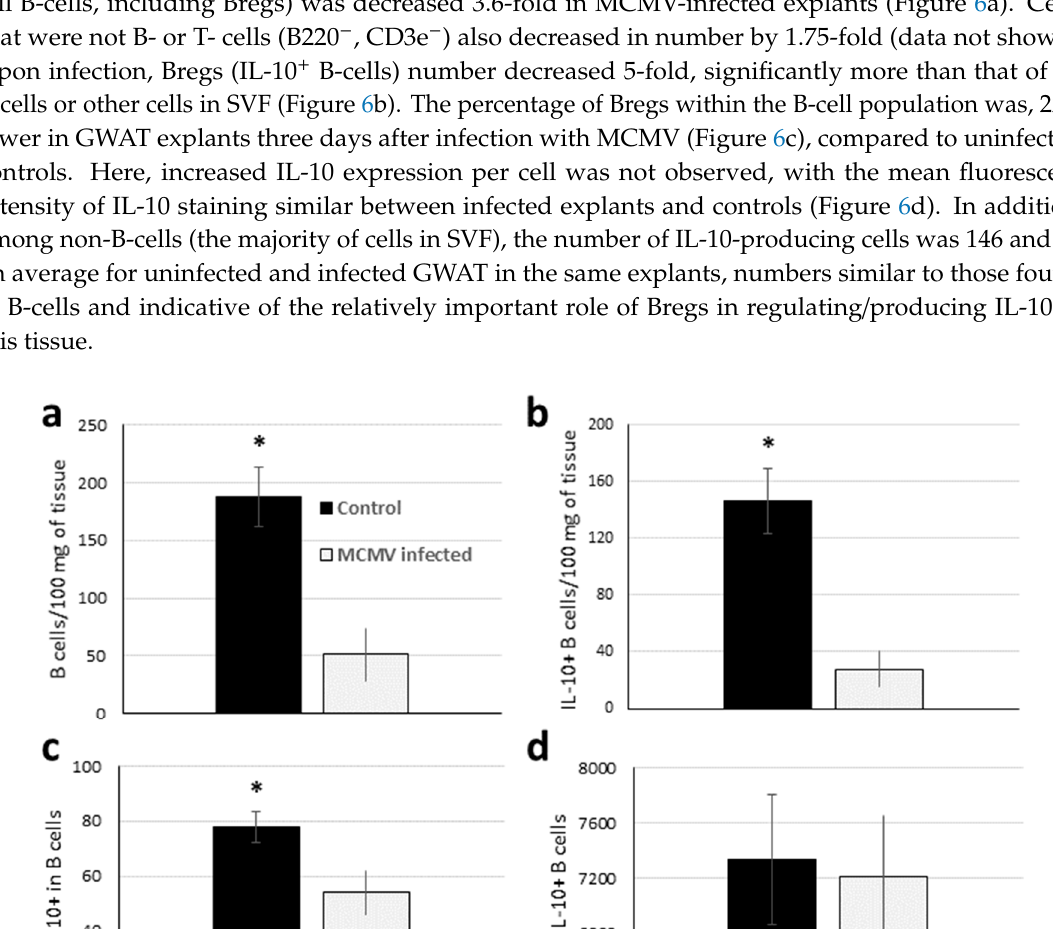
Figure 5. Inflammatory cytokines secreted by murine GWAT explant cultures after infection with MCMV. Explants were infected with 100,000 PFU/mL of MCMV or mock infected (isovolumetric TES buffer [0.01 M Tris-HCI, 0.002 M EDTA and 0.15 M NaCI at pH 7–7.2]) and the cytokine levels were evaluated in the supernatants daily for three days. Cytokine levels are normalized by the amount of tissue in each well at the start of infection. A total of six explants from different animals were tested in each condition in two independent experiments. Data points are average values ( n = 6) from two different experiments. Error bars denote SEM. Ratios IL-6/IL-10 and TNF α /IL-10 are expressed in arbitrary units (a.u.). *, **, and *** correspond to p value ≤ 0.1, 0.05, and 0.01, respectively, according to Sidak’s multiple comparisons test.